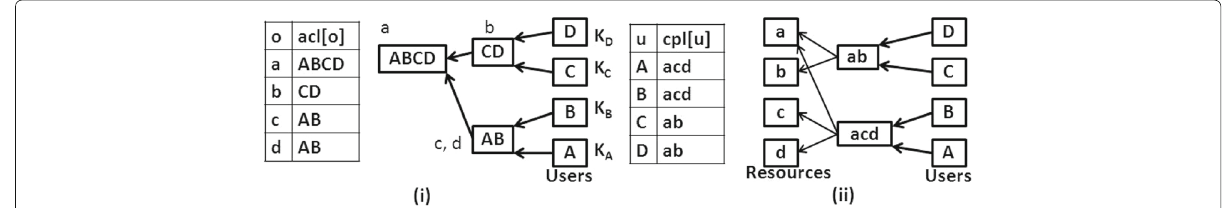
Fig. 2 Example hierarchy structures based on ( i ) ACLs ( ii )